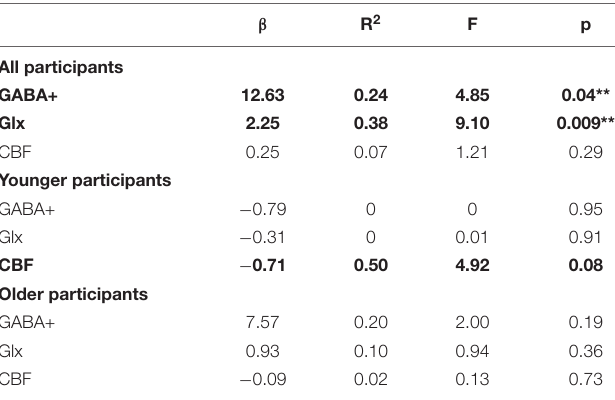
TABLE 3 | Model relating VO2max to neurophysiological measures gamma-aminobutyric acid+ (GABA+), glutamate-glutamine complex (Glx), and cerebral blood flow